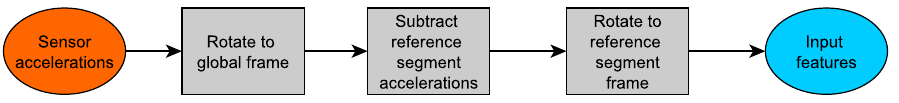
Figure 2. Processing of the measured sensor accelerations to be suitable input to the recurrent neural network (RNN) and stacked input neural network